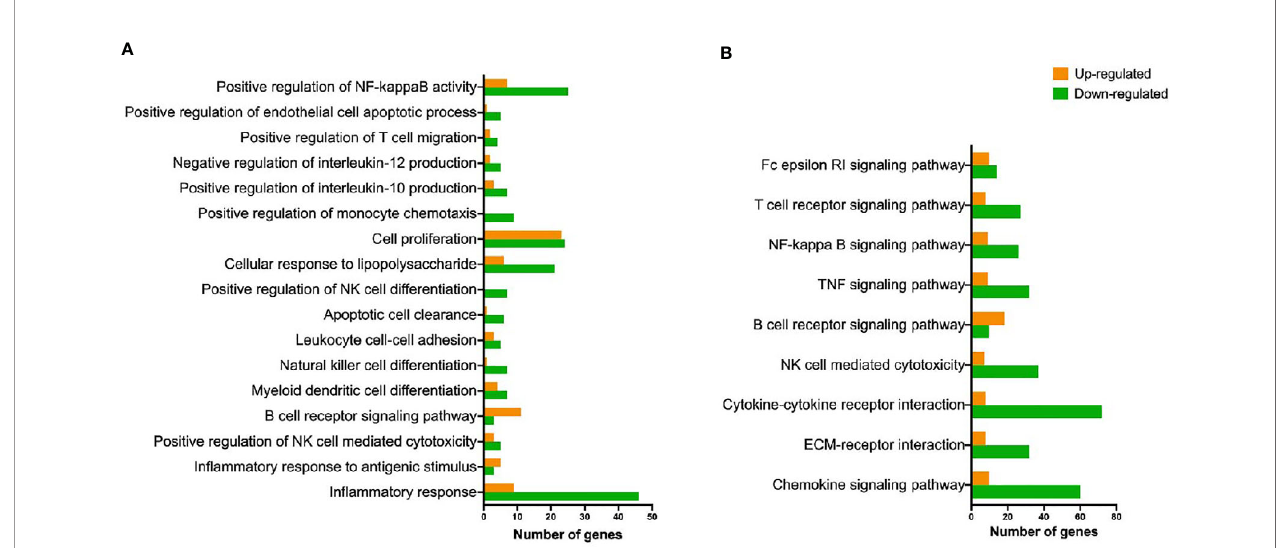
FIGURE 4 | Representation of GO biological processes and KEGG pathways detected as up- and down-regulated. (A) Biological processes terms (gene ontology) overrepresented in ovine hepatic lymph node after F hepatica infection. (B) Overrepresented KEGG pathways found in ovine hepatic lymph nodes after F hepatica infection.